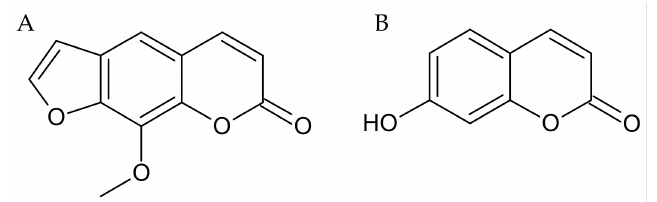
Figure 1. Chemical structure of ( A ) xanthotoxin and ( B ) umbelliferone. Previously, xanthotoxin and umbelliferone have shown an inhibitory effect towards butyrylcholinesterase (BChE) and acetylcholinesterase (AChE) [18,19]. Moreover, xantho- toxin exhibits moderate antioxidant properties in FRAP assay [18] that may be important for neuroprotective effect against reactive oxygen species (ROS), resulting from prooxidant- antioxidant imbalance during chronic neuroinflammation. Our previous studies revealed that umbelliferone, xanthotoxin, and bergapten prolonged the anti-depressant and procog- nitive activity of nicotine [20]. Furthermore, imperatorin, C-8 substituted structural analog of xanthotoxin, exerted the anxiolytic and procognitive effects [21]. Improvement of mem- ory and learning processes was revealed in scopolamine-induced dementia in the passive avoidance (PA) paradigm [22]. Similarly, xanthotoxin showed procognitive effects after acute and subchronic injections in scopolamine-induced memory disturbance in mice [23]. Based on our studies, we suggest that antioxidant properties, and cholinergic mechanisms are involved in these effects. However, memory loss is a multifactorial process. Therefore, searching for new compounds that improve memory processes and deepening knowledge about its mechanisms of action is